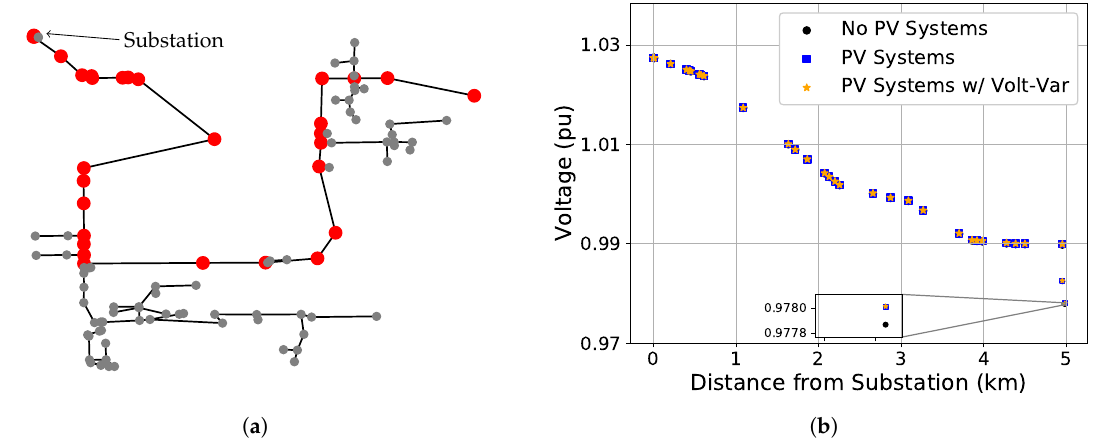
Figure 7. The Unnamed feeder’s voltage profile showed a significant drop from the substation to the PV system at the edge of the grid. The additional PV system caused a slight increase in voltage to occur that was only mitigated slightly by VVC controls. ( a ) feeder map and path for voltage profile; ( b ) the voltage profile for primary and secondary lines with and without PV and with Volt-Var Curve